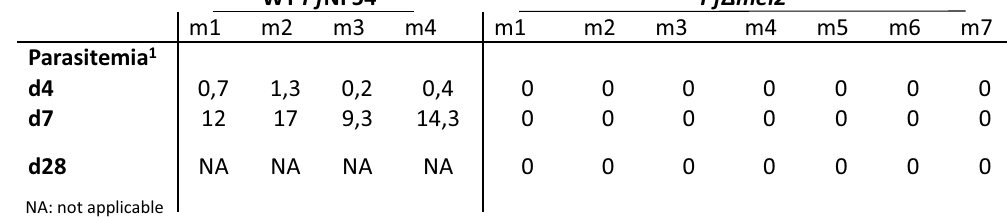
Fig. 3 Development of Pf Δ mei2 in FRG huHep mice containing human red blood cells. a Timeline of experiments in liver-chimeric mice where mice were injected intravenously (IV) with 1 × 10(6) sporozoites on day 0 and then with human red blood cells (h) on days 5 and 6 prior to emergence of blood-stage parasites. Blood samples were taken on days 7 and 9 for qRT-PCR with day 9 samples used for 28-day in vitro culture of blood stages with subsequent parasitaemia readout by microscopy and qRT-PCR. b 18 S qPCR analysis of blood samples from FRG huHep mice on day 7 and 9 after infection with 1 × 10(6) sporozoites of Pf Δ mei2 ( n = 7 mice) and WT Pf NF54 ( n = 4 mice). Signi fi cance values (unpaired Mann – Whitney test): ** p < 0.001. Dotted line: the cutoff as used in controlled human malaria infection (CHMI) at OHSU of 5 parasites/ml, assuming 7400 18 S copies/per parasite. c Analysis of blood samples from FRG huHep mice for presence of blood-stage parasites by in vitro cultivation of blood stages. Cultures, maintained in a semi-automated shaker system, were monitored for blood-stages for 28 days by microscopy analysis of Giemsa-stained thin and thick blood smears (see d ) and by 18 S qPCR. Signi fi cance values (unpaired Mann – Whitney test): ** p < 0.001. Dotted line: the 10 parasites/ml cutoff used in CHMI at LUMC, assuming 4252 18 S copies per parasite. d Blood-stage parasites in cultured blood samples collected from FRG huHep mice (m) after infection with Pf Δ mei2 and WT PfNF54 sporozoites. Samples from in vitro cultures were analyzed at different days ( d ) for blood-stage parasitemia by microscopy (% of infected Four different plasmids with heterologous DNA sequences were genetic makeup of the parasites, in particular a con fi rmation of used to create Pf Δ mei2 , speci fi cally, (i) a donor DNA plasmid absence of unwanted genetic alterations which may impact the containing two 34 bp frt (GAAGTTCCTATACTTTCTAGAGAATAG- virulence of Pf Δ mei2 parasites, is crucial for regulatory approval of GAACTTC) sequences; (ii) two sgRNA plasmids containing the their clinical use. We therefore analyzed the presence of heterologous selectable-marker genes bsd , h dhfr and y fcu fl anked undesirable integration of plasmid DNA sequences that were by 3 ′ and 5 ′ -utr sequences of P. falciparum -speci fi c genes, used to generate Pf Δ mei2 and the presence of other genome employed to delete mei2 by double cross-over integration; (iii) a rearrangements that might result from the genetic modi fi cation or fourth plasmid, containing a yeast FLPe recombinase expression mutations that may affect gene expression or drug-sensitivity.